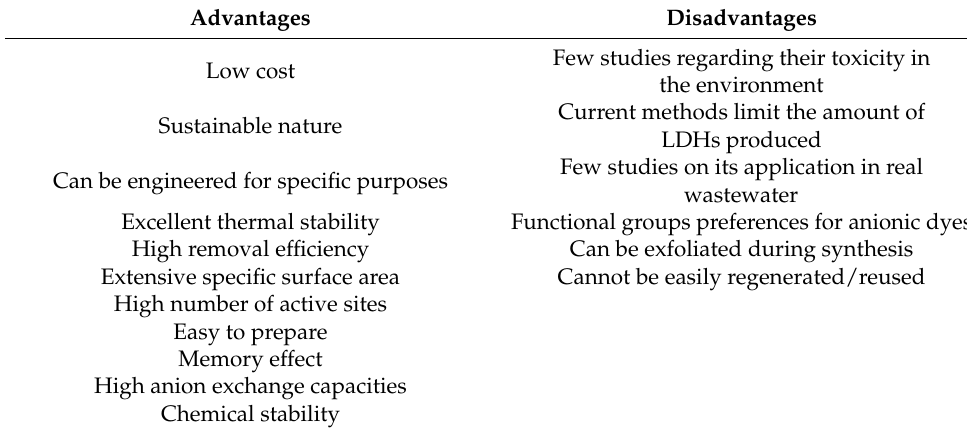
Table 1. Advantages and disadvantages of using LDH in water